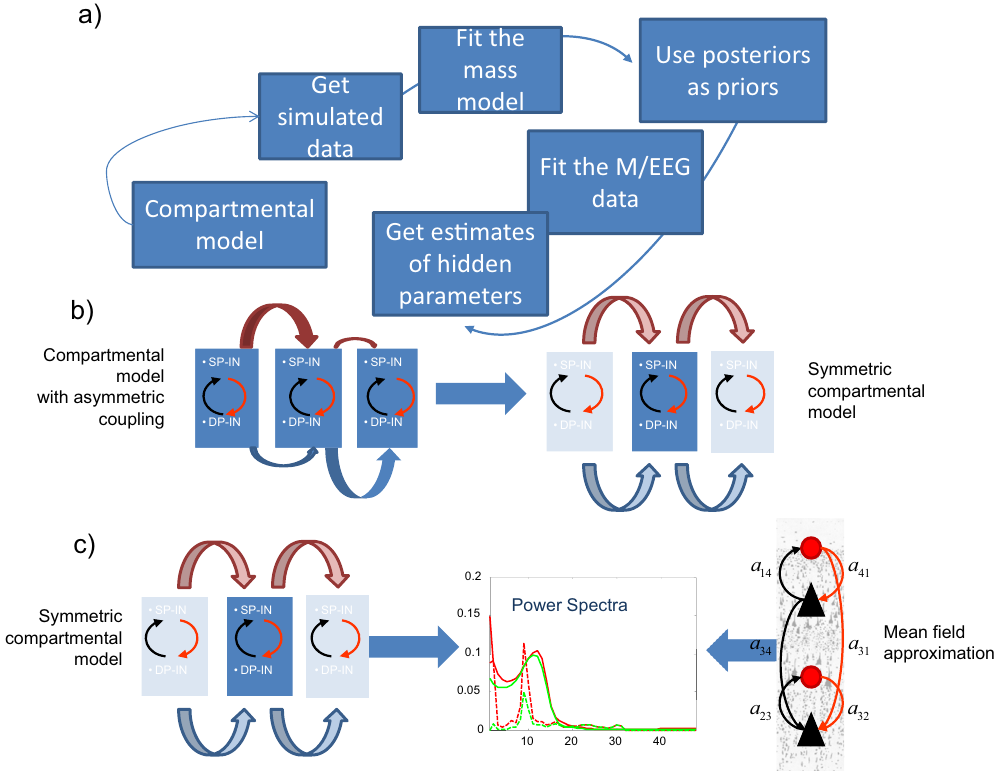
Fig. 2 Outline. a Schematic of our analysis pipeline. This summarizes the steps of our approach: 1. Simulate data from the compartmental model. 2. Fit the mass model to these data. 3. Use the parameter estimates obtained as priors for fi tting M/EEG data. 4. Obtain hidden parameters that describe laminar dynamics. b Construction of the neural mass model: We fi rst establish a similarity between the model of ref. 5 and its symmetric variant. Here horizontal arrows of different widths in the left panel denote asymmetric connectivities and delays between mini-columns depicted as rectangles containing Super fi cial and Deep Pyramidal cells (SP and DP) and Inhibitory Interneurons (IN). In the right panel, a symmetrization of the compartmental model reduces the number of connectivity parameters to be the same as those in a homologous neural mass model. c Construct validity of the mass model. To demonstrate this, we fi tted the mass model to synthetic (laminar) data obtained from its compartmental homologue. This is justi fi ed by statistical decision theory. Red and green lines in the middle panel correspond to real data and model predictions. Solid and dashed lines to real and imaginary parts of crossspectra between deep and super fi cial pyramidal neurons.